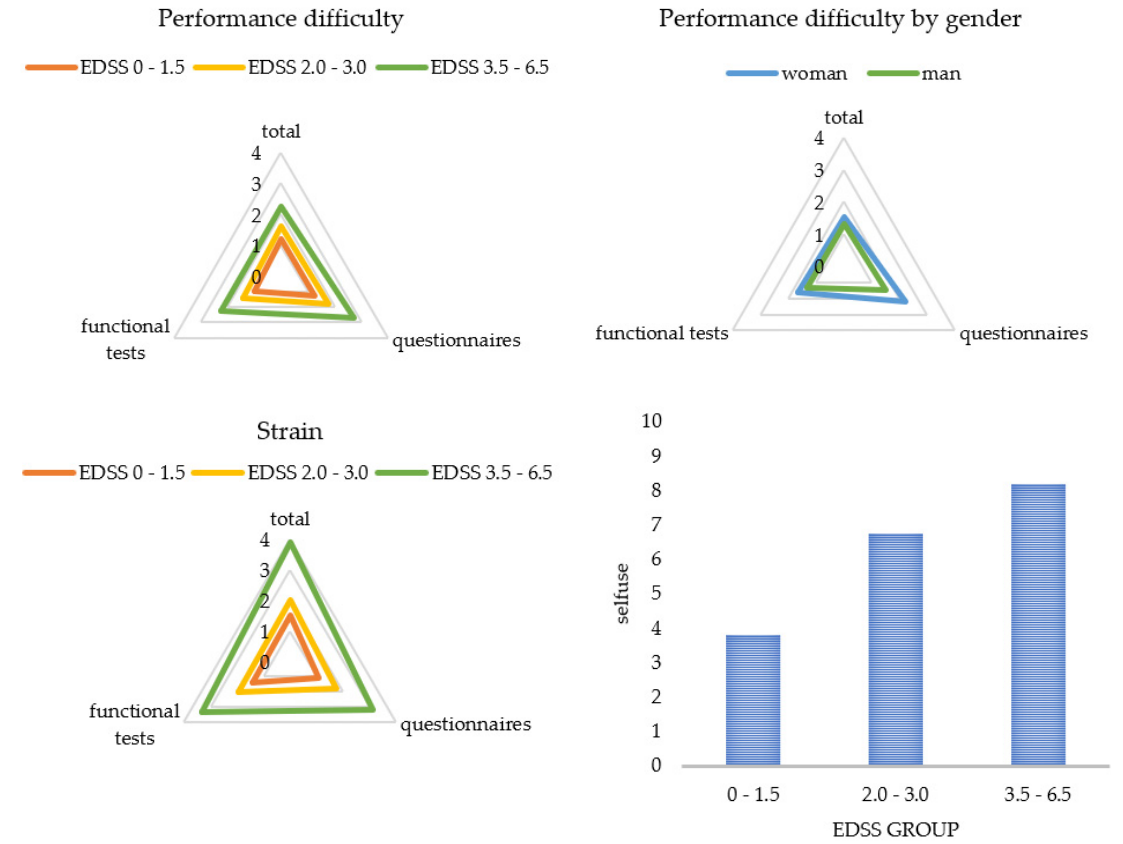
Figure 3. Patient ratings for each subcategory by subgroups. Categories were rated on a scale from 0 (not at all) to 10 (extremely). Presented are mean values of the categories. EDSS = Expanded Disability Status Scale.